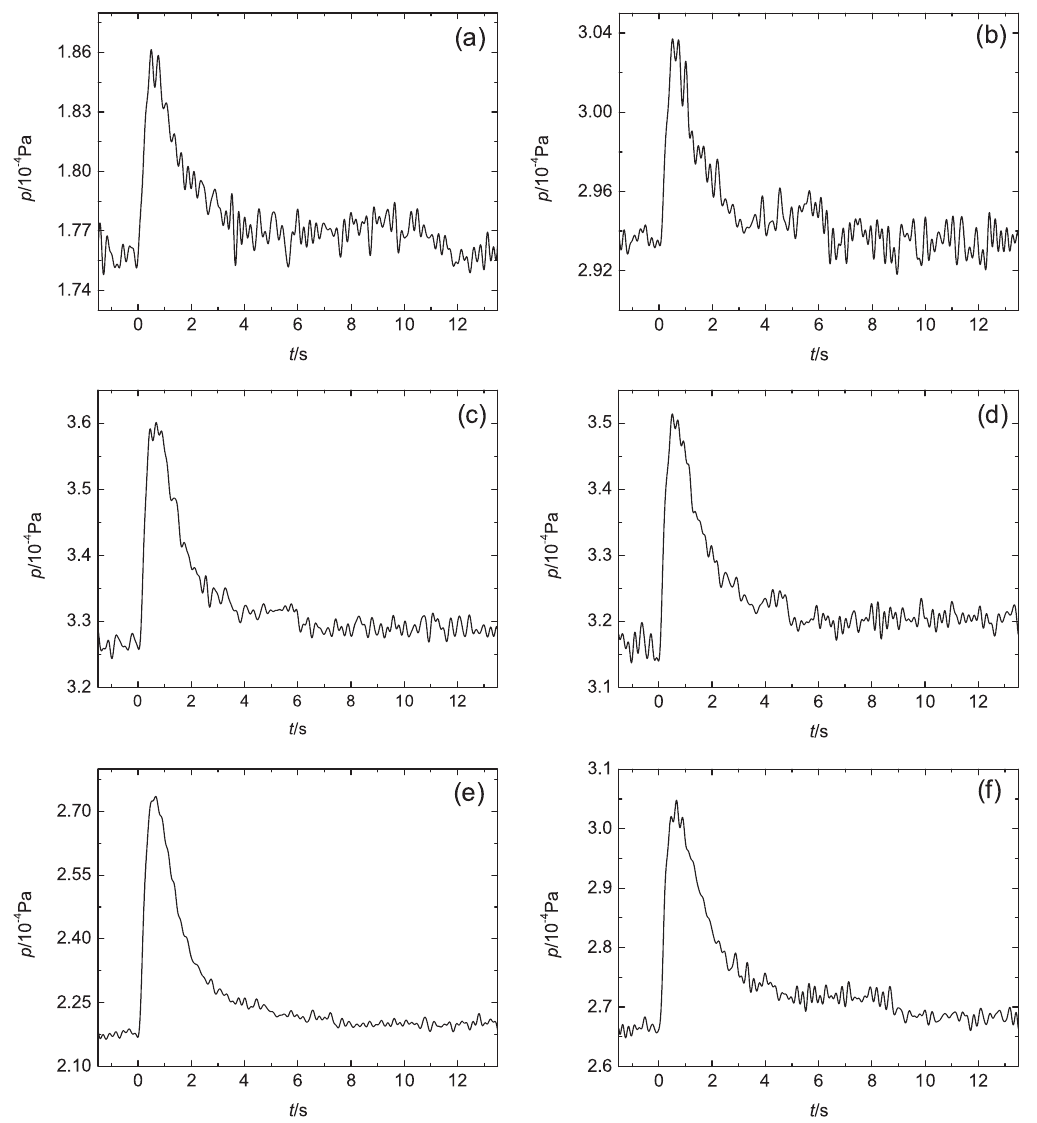
FIG. 6. Temporal variation pressure in different diode voltages: (a) U ¼ 1 : 33 MV , (b) U ¼ 1 : 37 MV , (c) U ¼ 1 : 46 MV ,